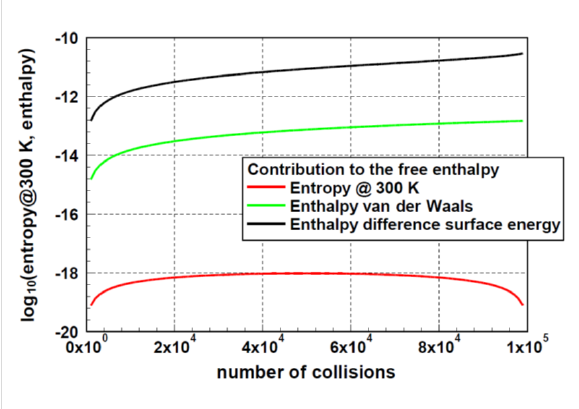
Figure 7: Comparison of the different possible contributions to the free enthalpy as function of the number of collisions for an ensemble of 10 5 particles. Assuming a temperature of 300 K, one realizes that the contribution of the entropy is by far the smallest. The surface-related enthalpy was calculated assuming a particle size of 10 nm and the for- mation of complete new particles. As this difference is negative, for this plot the absolute value was used. Even, if one assumes only 1% of the surface as newly coagulated, this contribution remains by far the largest